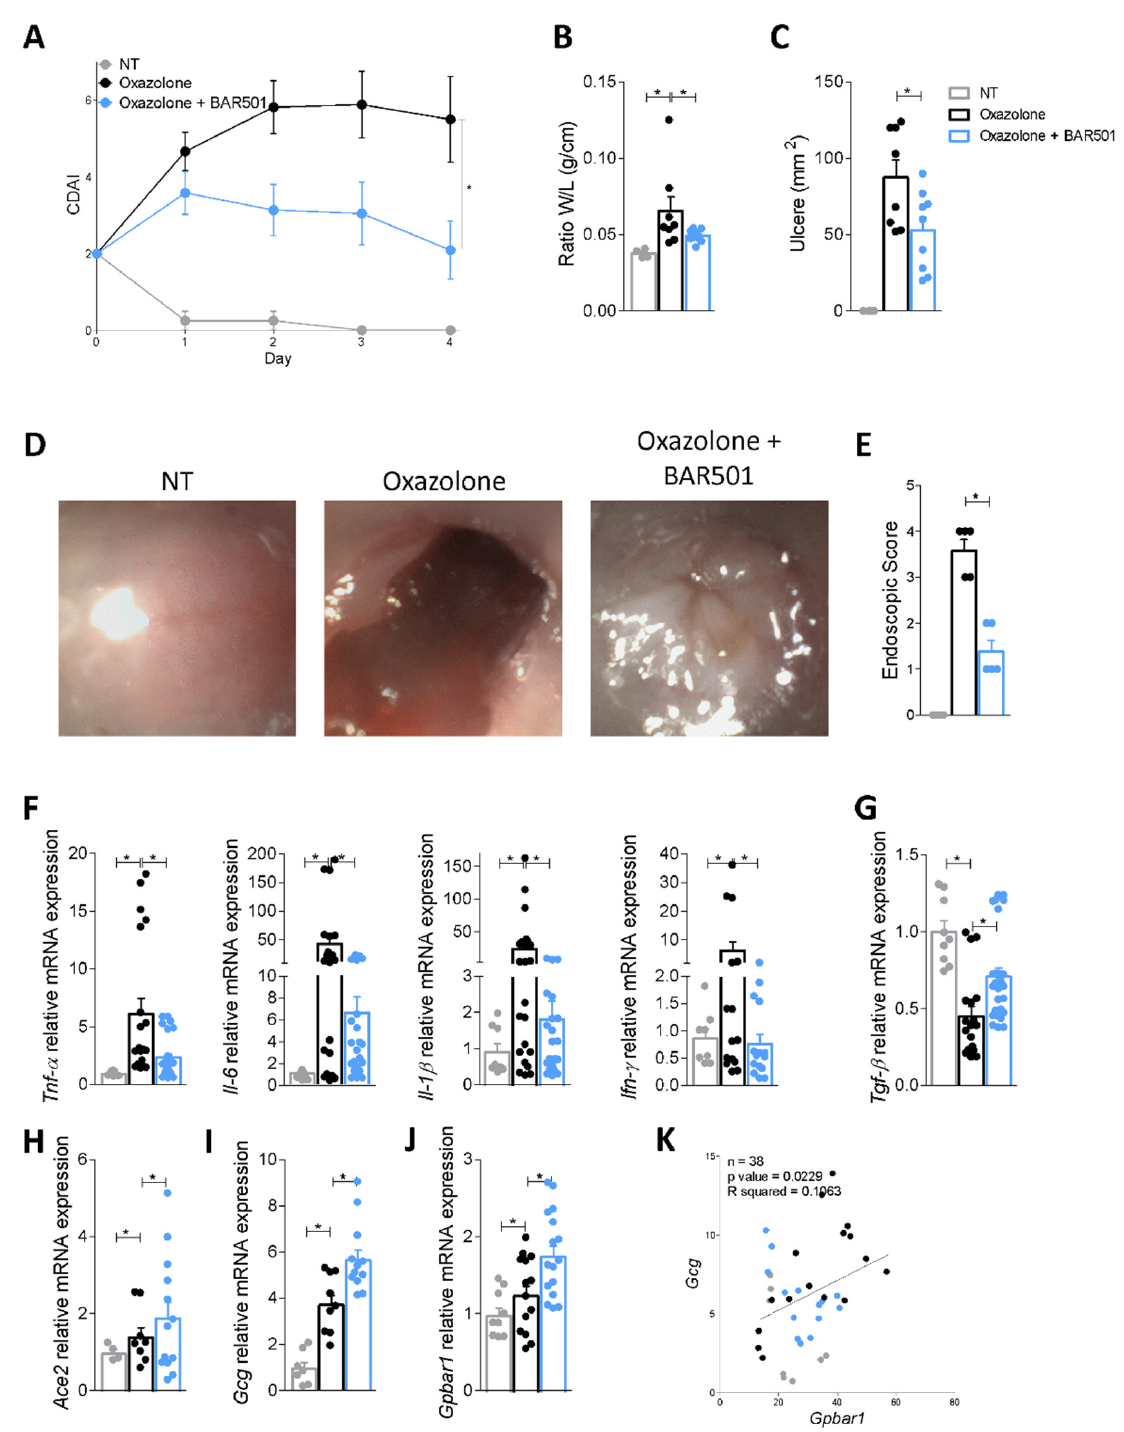
Figure 5. Administration of the GPBAR1 agonist further increases Ace2 expression. Colitis was induced in Balb/c male mice with administration of oxazolone per rectum alone or in combination with BAR501 (30 mg/Kg). Disease severity was scored by the following evaluations ( A ) Colitis Disease Activity Index (CDAI), ( B ) ratio of weight (W)/length (L) (g/cm) of colon, ( C ) colonic macro- scopic ulcers (mm 2 ), ( D ) endoscopy images and ( E ) endoscopic score. Relative mRNA expression levels of ( F ) Tnf- α , Il-1 β , Il-6 and Ifn- γ ; ( G ) the anti-inflammatory gene Tgf- β ; ( H ) Ace2; ( I ) Gcg and ( J ) Gpbar1. Data are normalized to Gapdh mRNA. Results are the mean ± SEM, each point represents a mouse; * p < 0.05. ( K ) Correlation graph between Gcg and Gpbar1 expression.